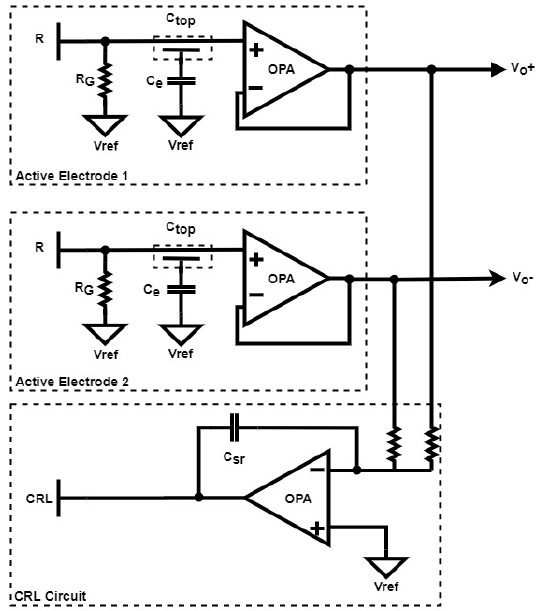
Figure 4. Common-mode noise cancelling circuit.